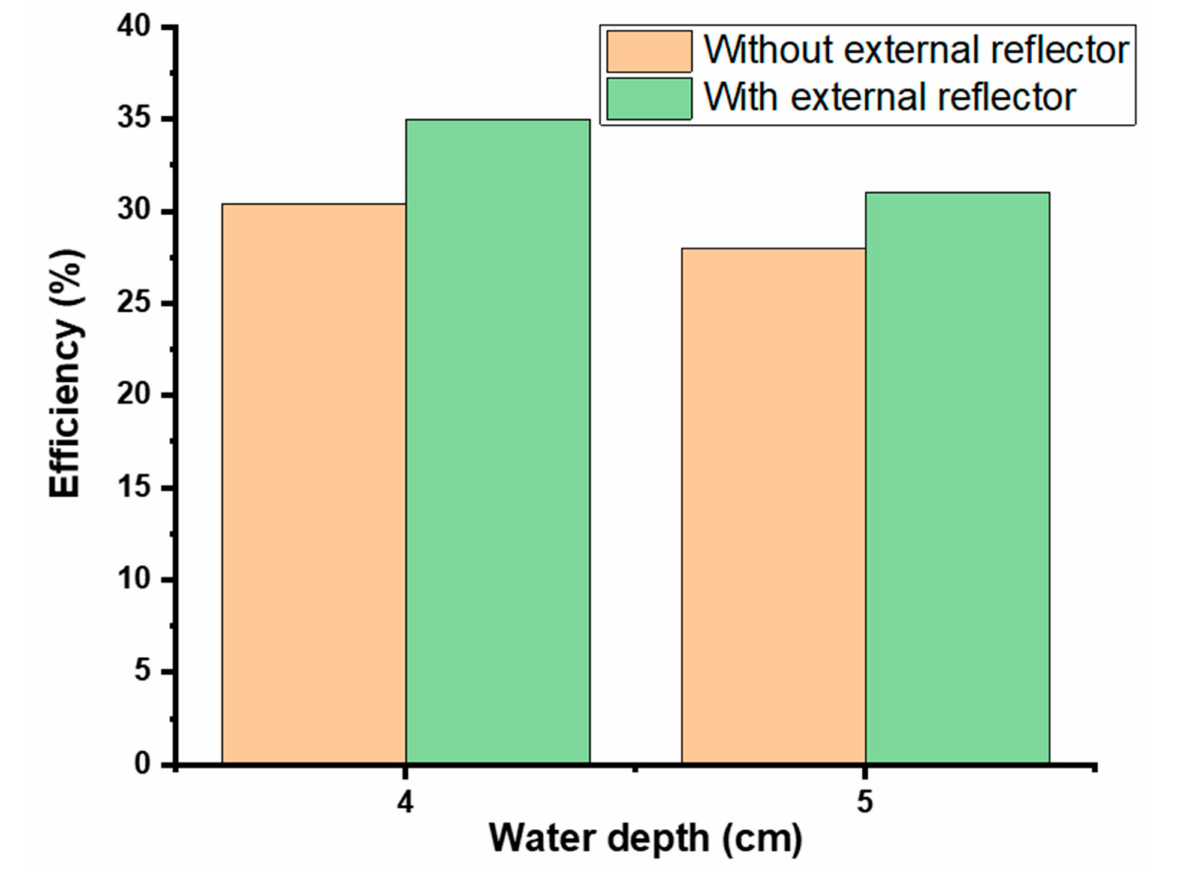
Figure 8. Comparison of efficiency with and without reflector for Case 1 and Case 2. Table 3. Overall productivity and efficiency of solar still with and without external reflectors. Tested Depths of Brackish